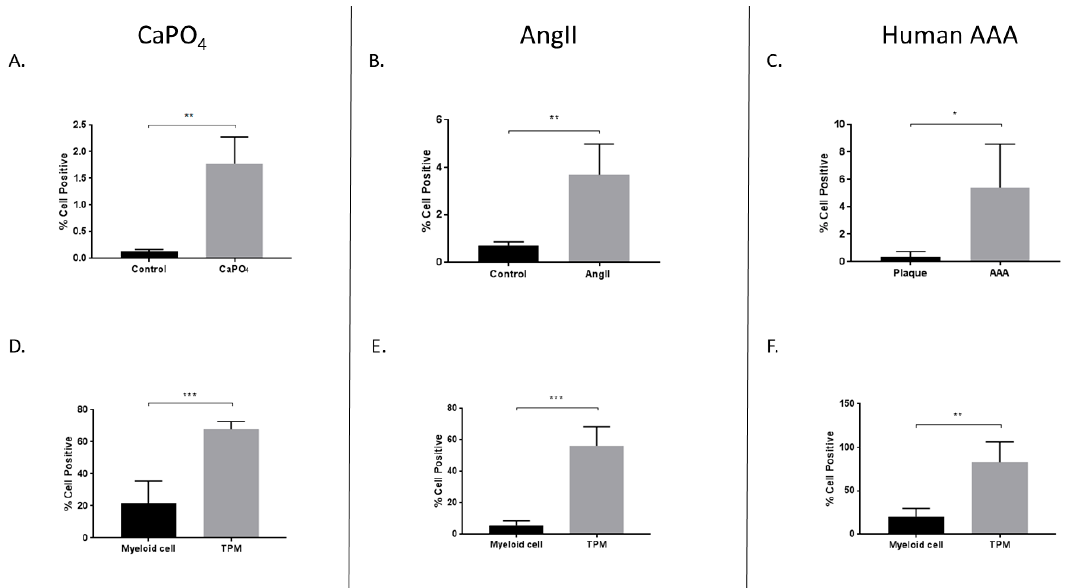
Figure 5. Increased expression of HIF-1 α in mouse CaPO 4 ( A , D ), mouse AngII ( B , E ), and human ( C , F ) aneurysms. Tissues from CaPO 4 mice ( n = 5), AngII mice ( n = 5) and PBS-only controls ( n = 3), human AAA ( n = 4), and human carotid plaques ( n = 3) were enzymatically digested and processed to obtain single cell suspensions for flow cytometric analysis, as described in the Methods section. ( A – C ) depict the percentage of live cells expressing HIF-1 α in aneurysmal and control tissues. ( D – F ) compare the percentage of live cells expressing HIF-1 α between myeloid cells (CD11b + , TRAP − ) and TPMs (CD11b + , TRAP + ) from aneurysmal tissues. Data are expressed as mean ± SEM. * p < 0.05, ** p < 0.01, *** p < 0.001. TPM, TRAP-positive macrophage. AAA, abdominal aortic aneurysm.